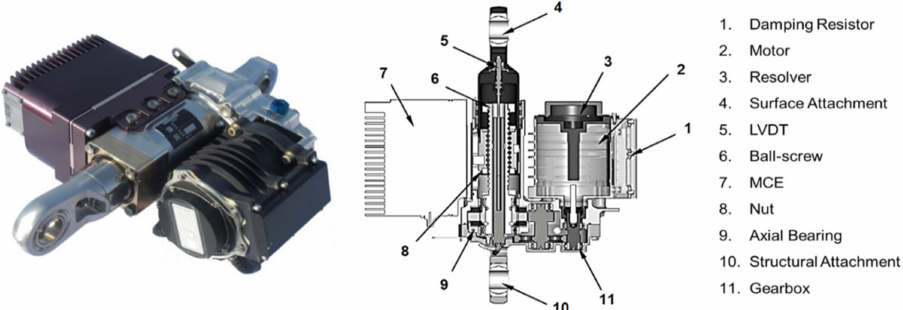
Figure 10. Example of geared linear EMA sized for Airbus A320 aileron actuation